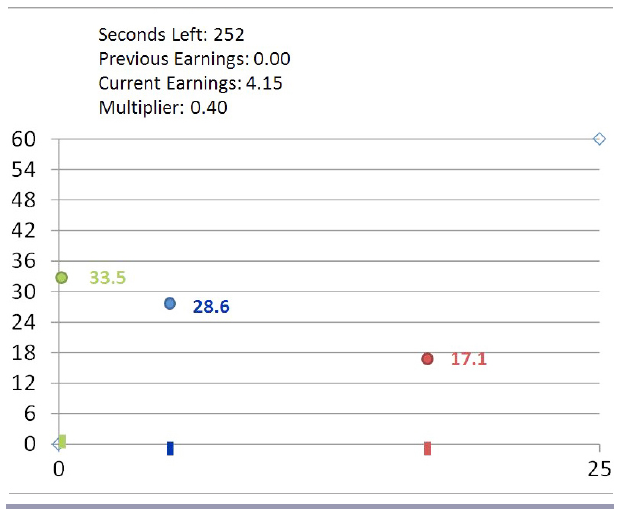
Fig. 8 . A screenshot of the ConG experimental environment in which participants have a certain time to define their level of investment in a public